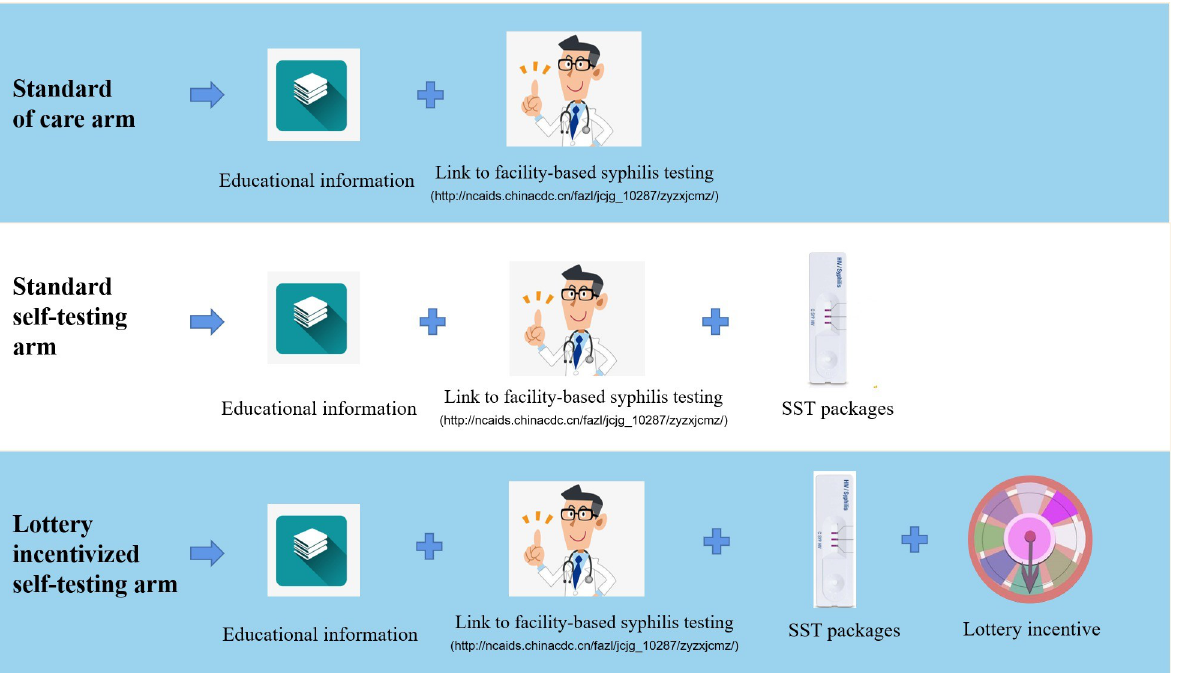
PLOS Medicine| https://doi.org/10.1371/journal.pmed.1003930 March 2,